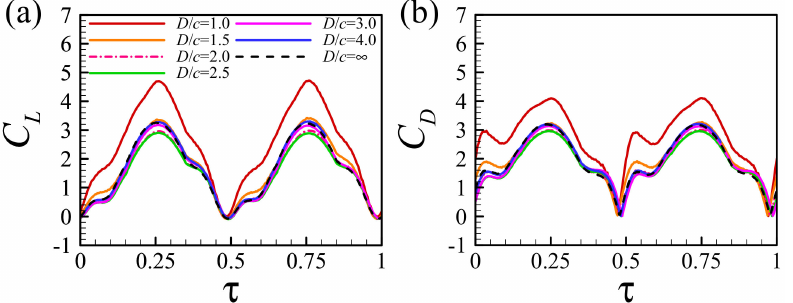
Figure 17. The transient aerodynamic ( a ) lift and ( b ) drag coefficient ( C L and C D ) distributions for one flapping cycle at systematic wall clearances ( D / c ) and Re =